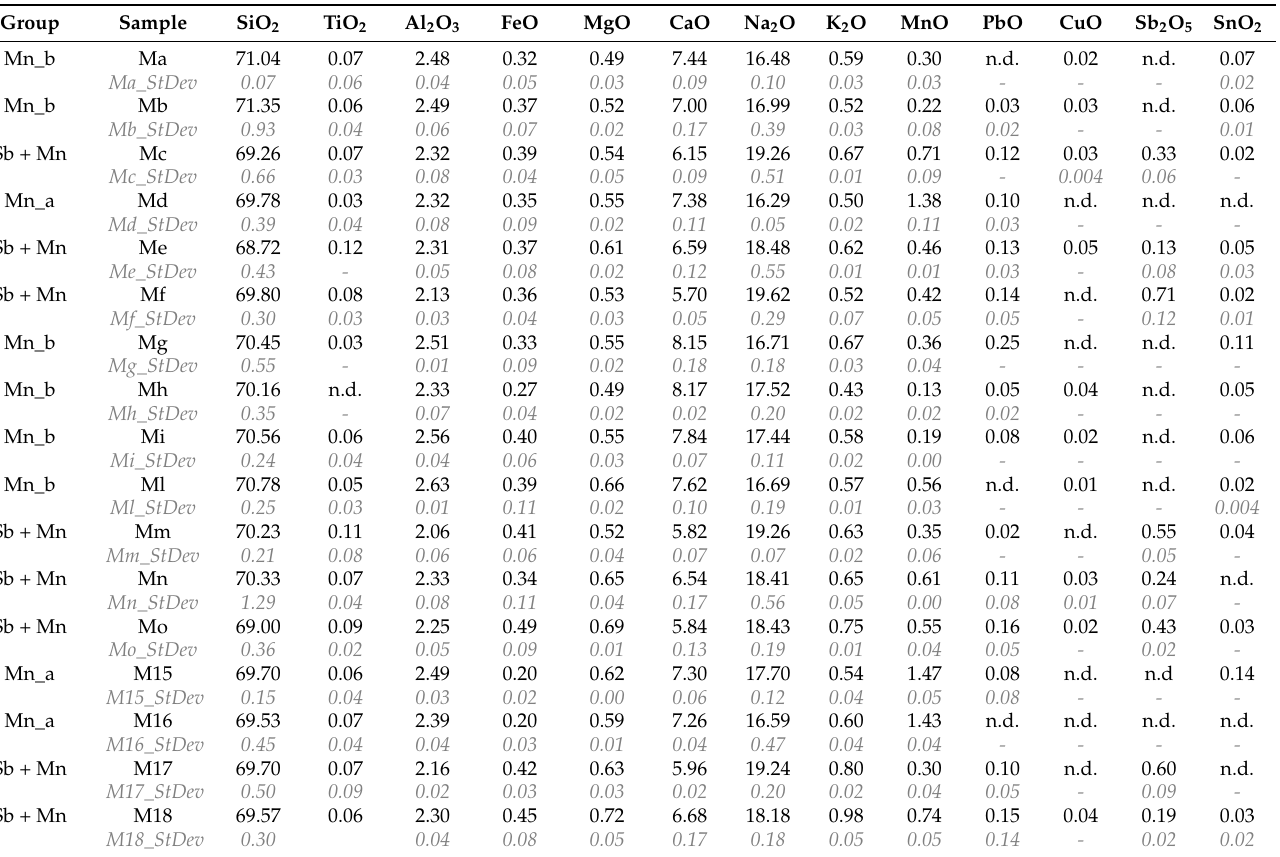
Table 3. Major element concentrations in wt% of oxides determined by EPMA. For each oxide, we calculated the standard deviation (StDev) of three